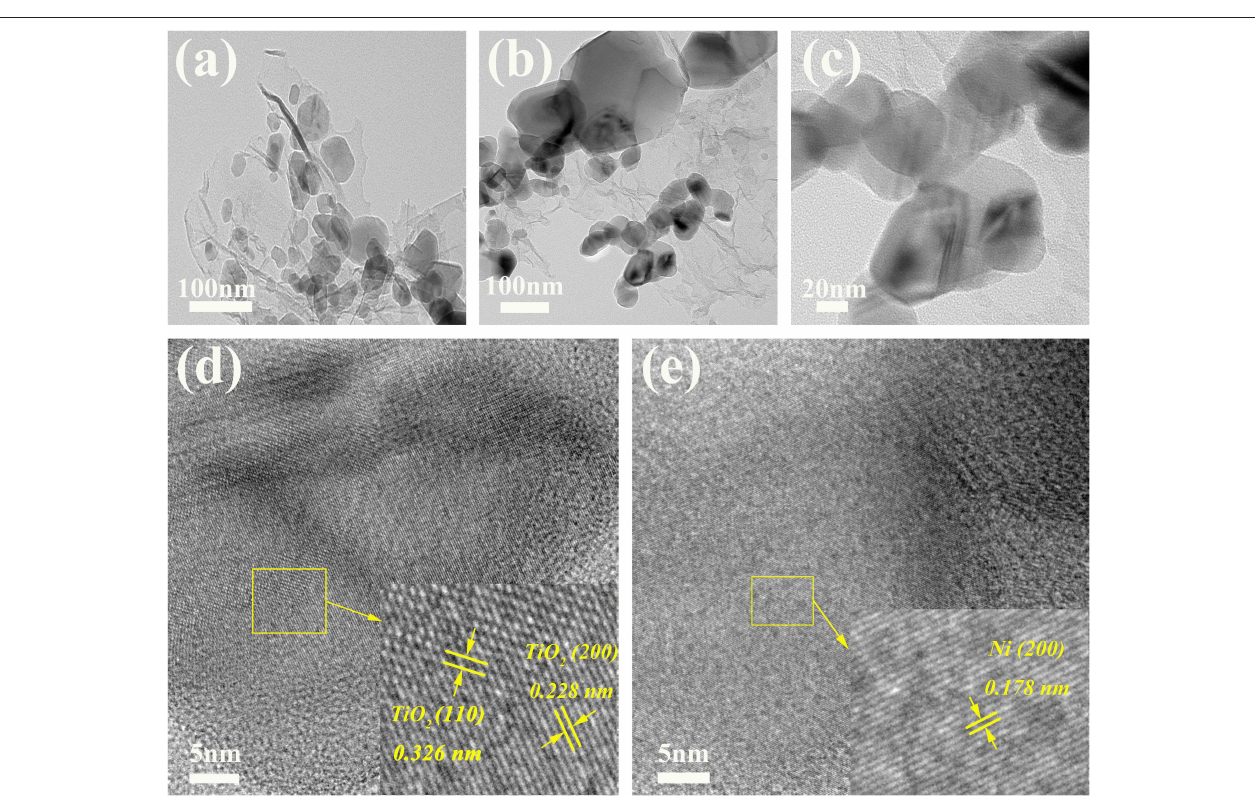
FIGURE 4 | TEM (a–c) and HRTEM (d,e) images of (Ni-TiO 2 )@rGO nanocomposites.